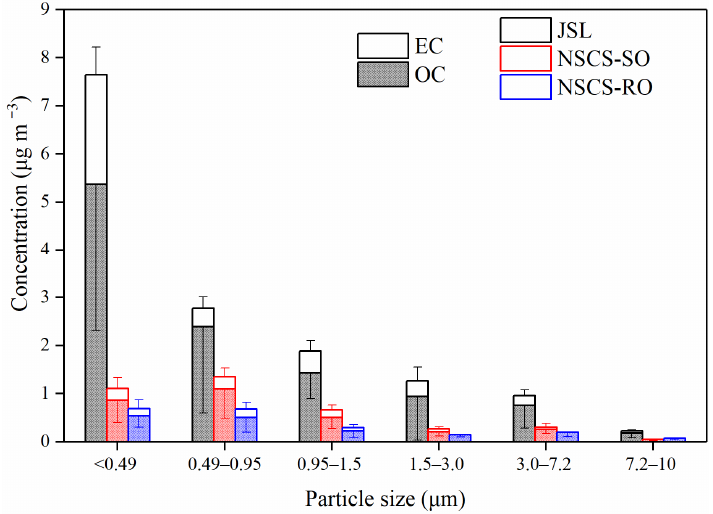
Figure 3. The concentrations of OC and EC in each particle size bin (the upper error bar represents the standard deviation of EC, and the lower error bar represents the standard deviation of OC).